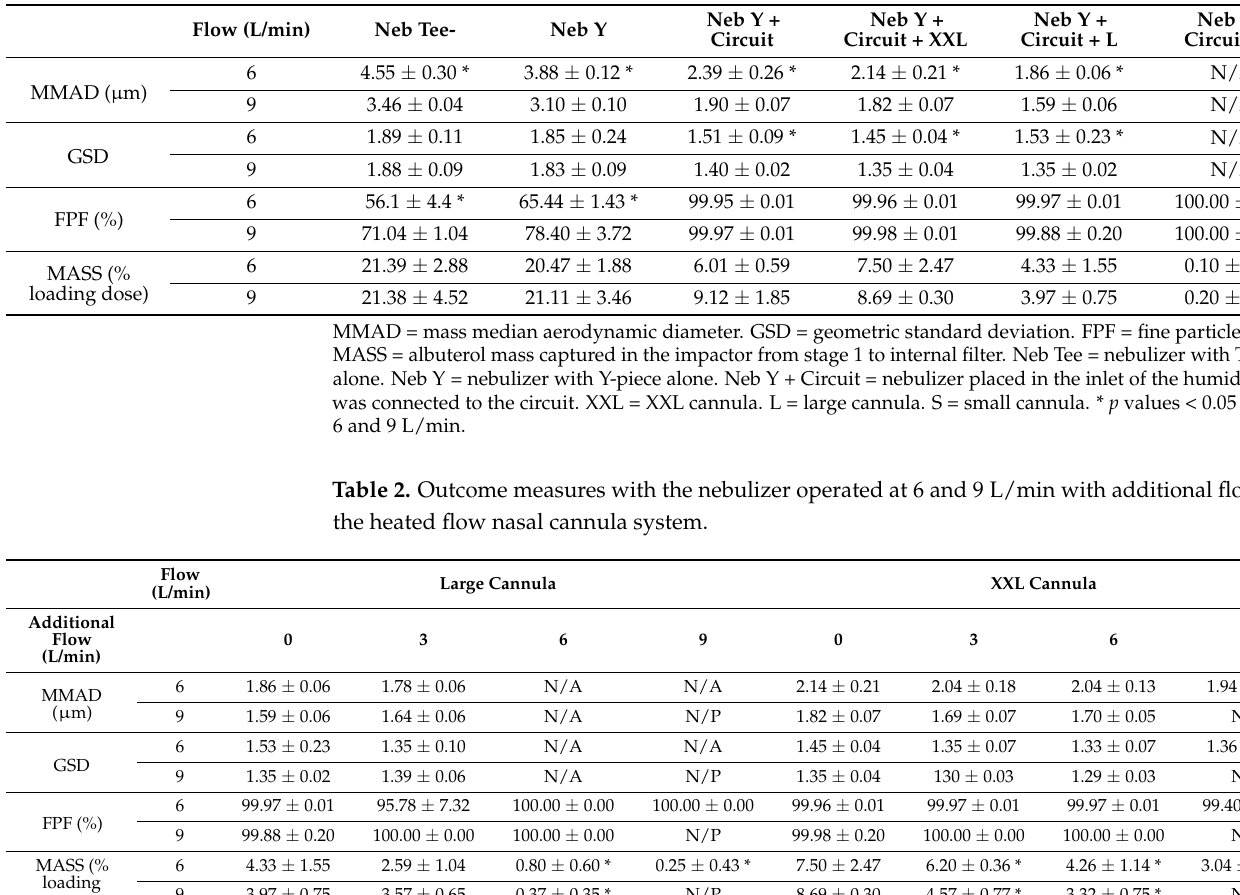
Table 1. Outcome measures with the nebulizer operated at 6 and 9 L/min.